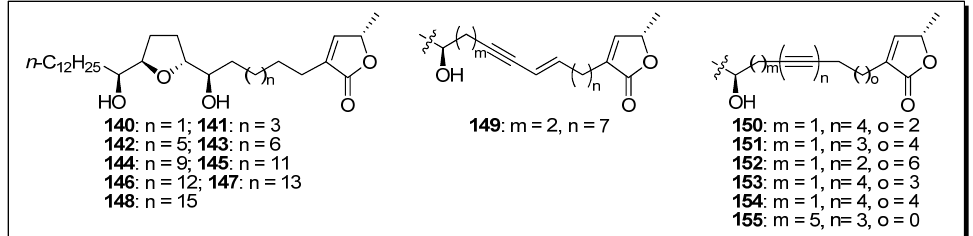
Figure 2. Design of analogues possessing modified alkyl spacers linking the THF and γ - lactone rings, by Miyoshi’s group.